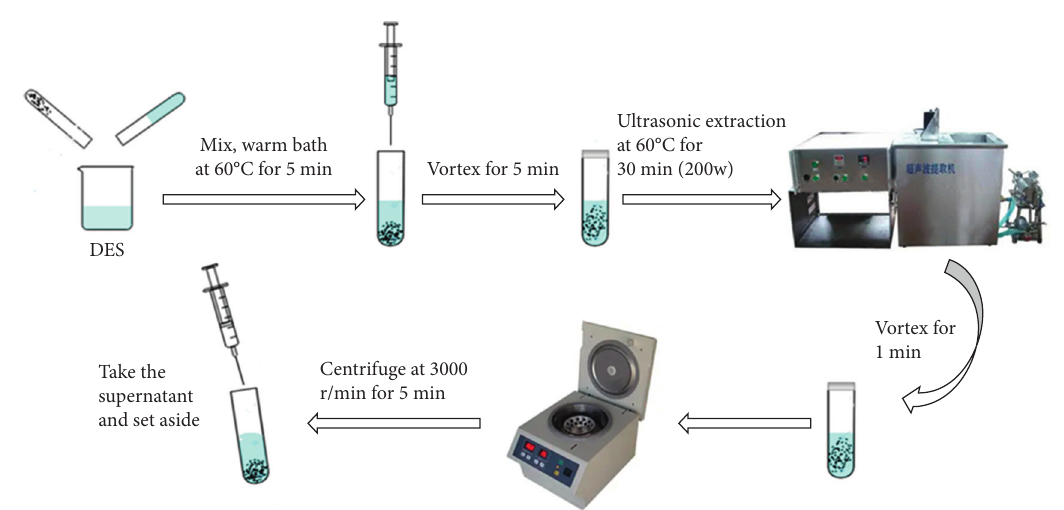
Figure 2: Preparation diagram of test